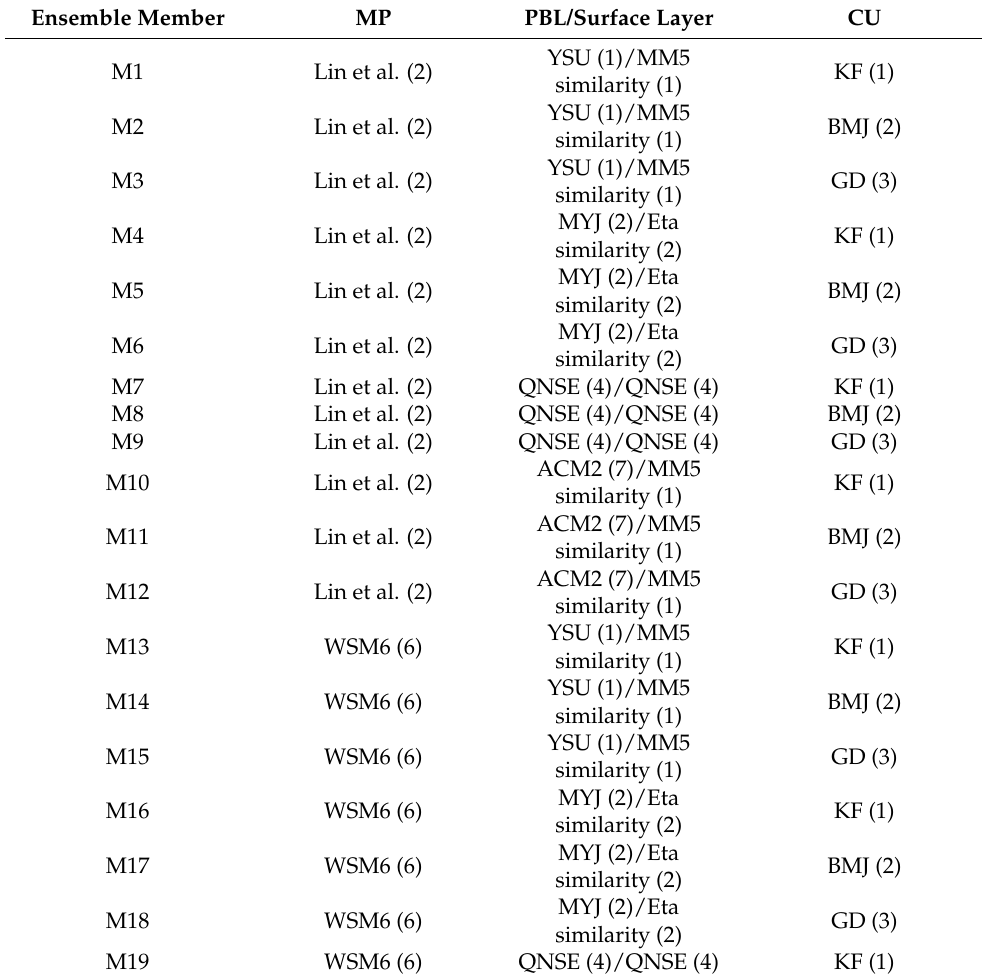
Table 1. Parameterization scheme combinations used to create ensemble members. The numbers in parentheses represent the physics options in WRF